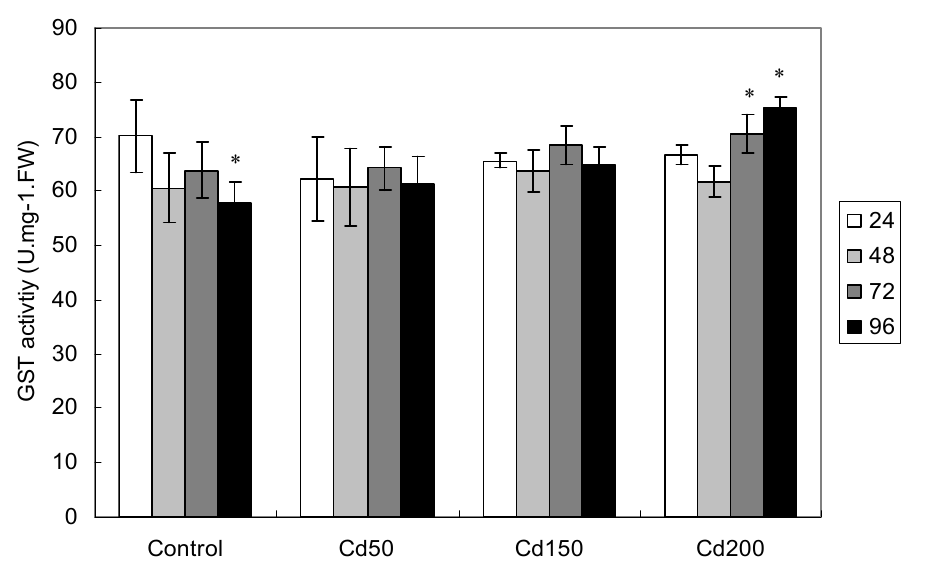
Figure 5 . GST concentration germinating soybean seeds after different periods of exposure. All values are mean ± SD (n = 4). * means significance at p < 0.05 as compared to control as compared to control. (the same